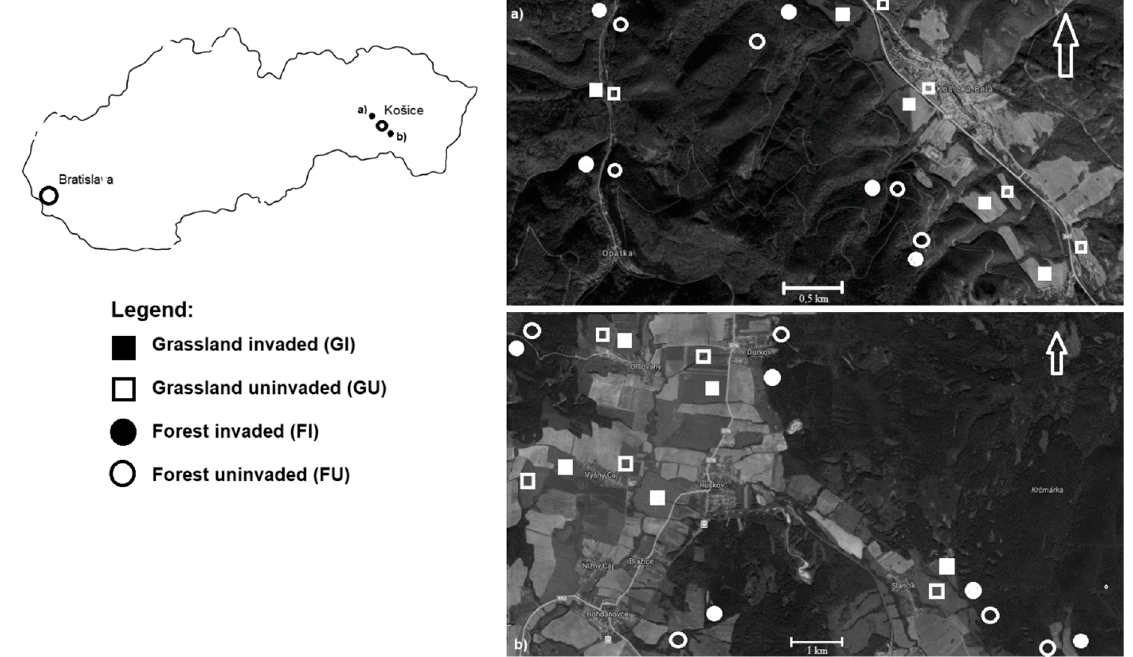
Figure 1. Experimental localities and sampling points of the studied area in Košice